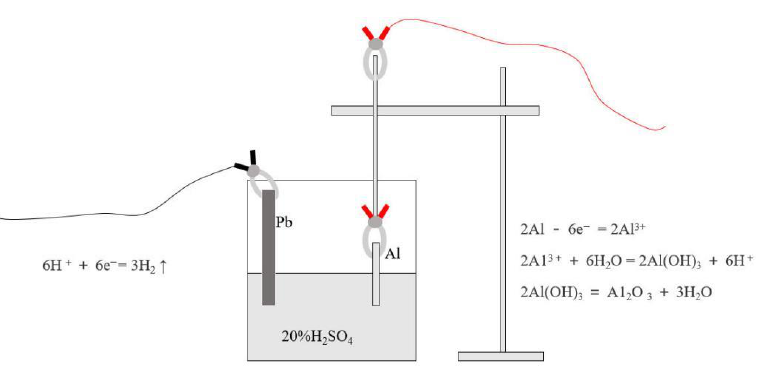
Figure 2. Schematic of the anodizing pretreatment on joining interface of the Al alloy.